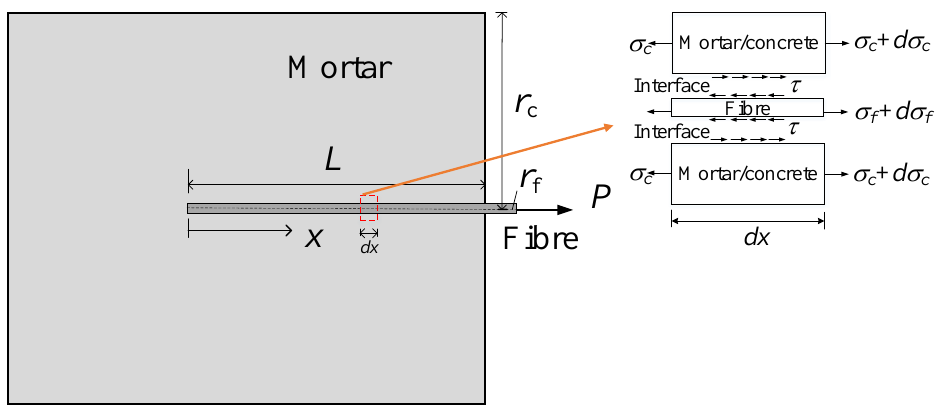
Figure 13. The idealized model of single fibre pullout tests.